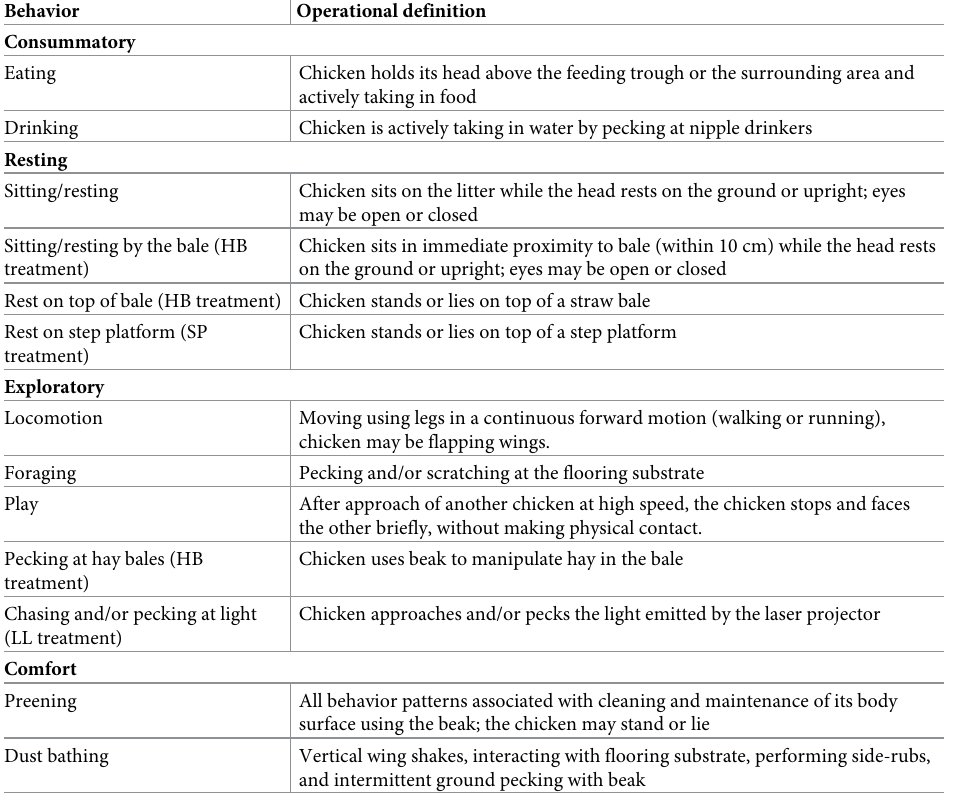
Table 1. Experimental ethogram of recorded broiler chicken behaviors, based on